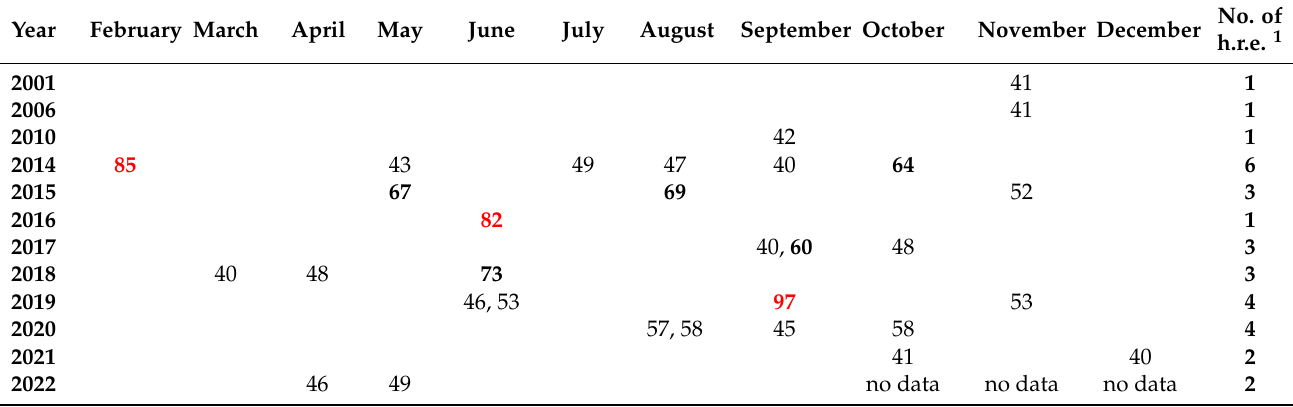
Table 4. Precipitation values of ≥ 40 mm per heavy rainfall event (h.r.e.) at Kravarsko